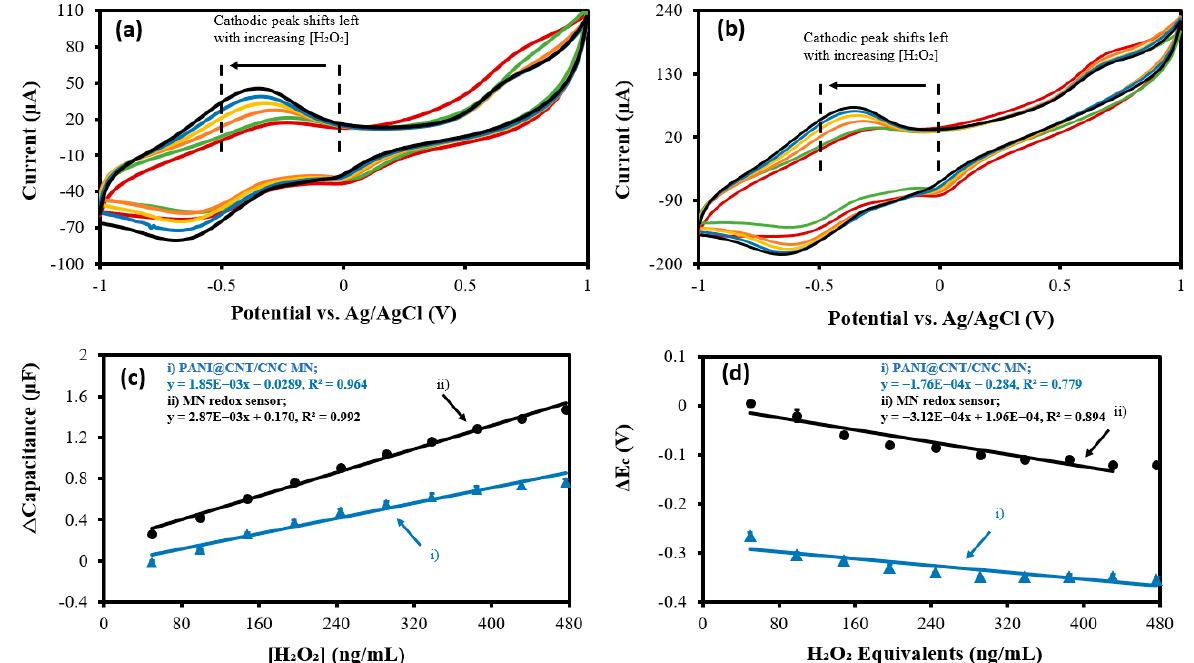
Figure 6. Representative overlapped CVs showing ( a ) MN redox sensor; and ( b ) PANI@CNT/CNC microneedle (MN) electrochemical response to 49.8–476 ng/mL H 2 O 2 and resulting ( c ) cathodic ∆ capacitance; and ( d ) ∆ E c vs. H 2 O 2 concentration plots obtained using the ( i ) PANI@CNT/CNC microneedle (MN) and ( ii ) MN redox sensor.